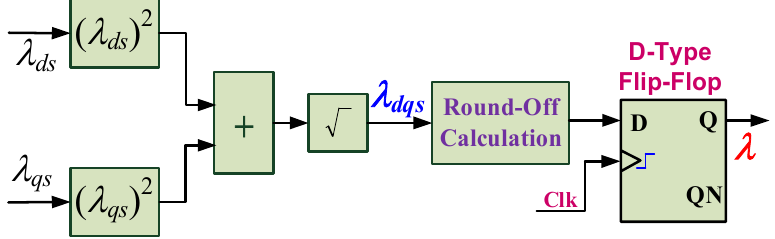
Figure 2. Calculation blocks of the synthetic flux with square root, round-off calculation, and DFF circuits.